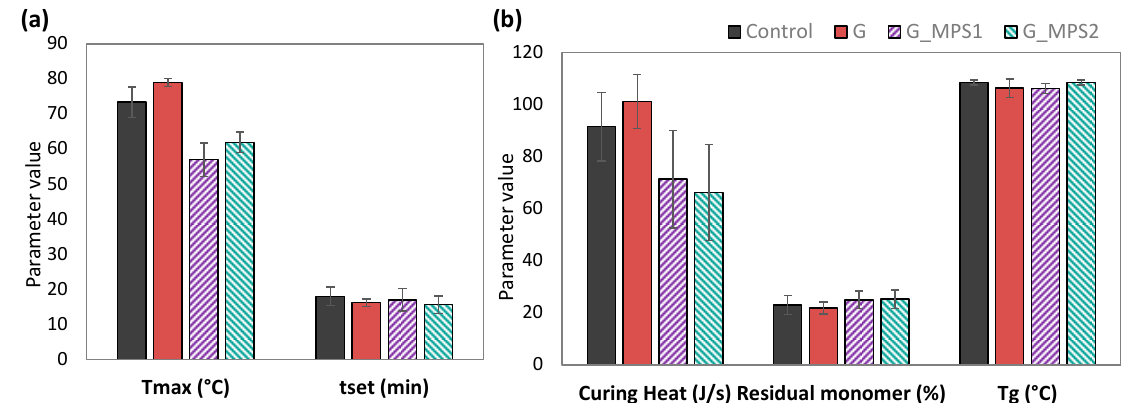
Figure 8. Thermal properties (mean ± SD): maximum temperature ( a ), setting time ( a ), curing heat ( b ), residual monomer ( b ) andglass transition temperature ( b ), for control and bone cements with 0.1 wt.% of G, G-MPS1 and G-MPS2.